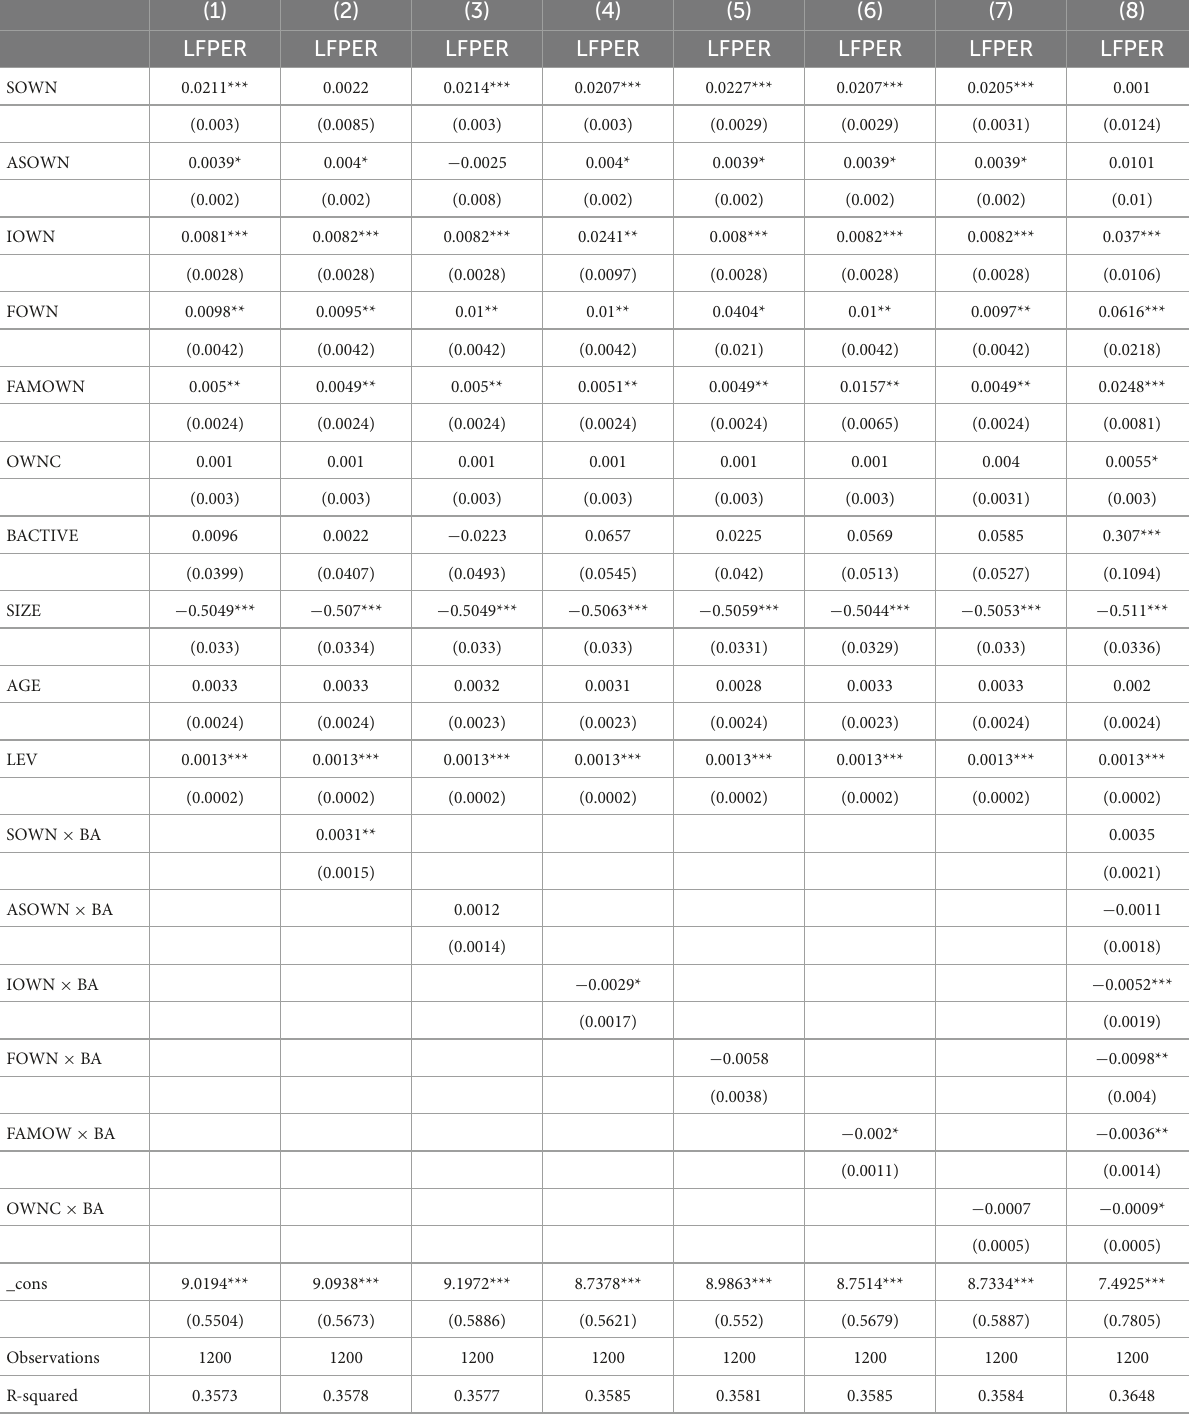
TABLE 5 Regression analysis of financial